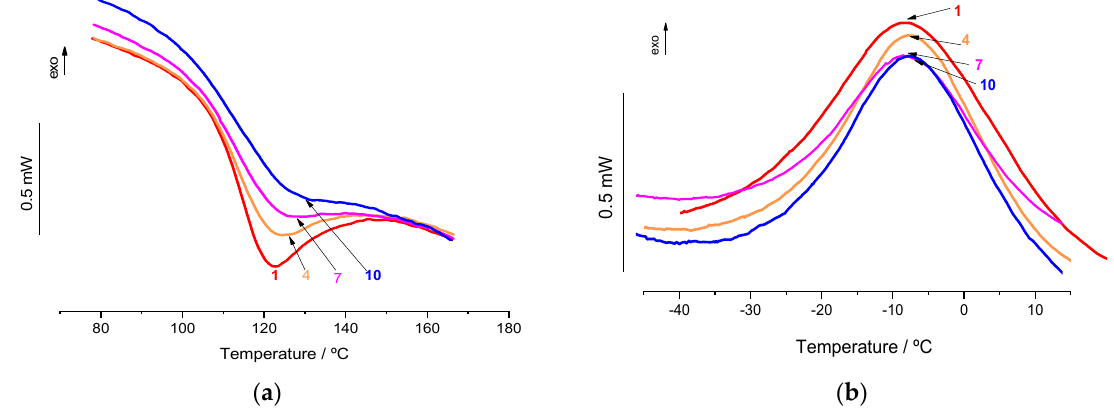
Figure 9. DSC peaks corresponding to the ε→γ transformation ( a ) and the reverse ε → γ transformation ( b ) for ten consecutive cycles.